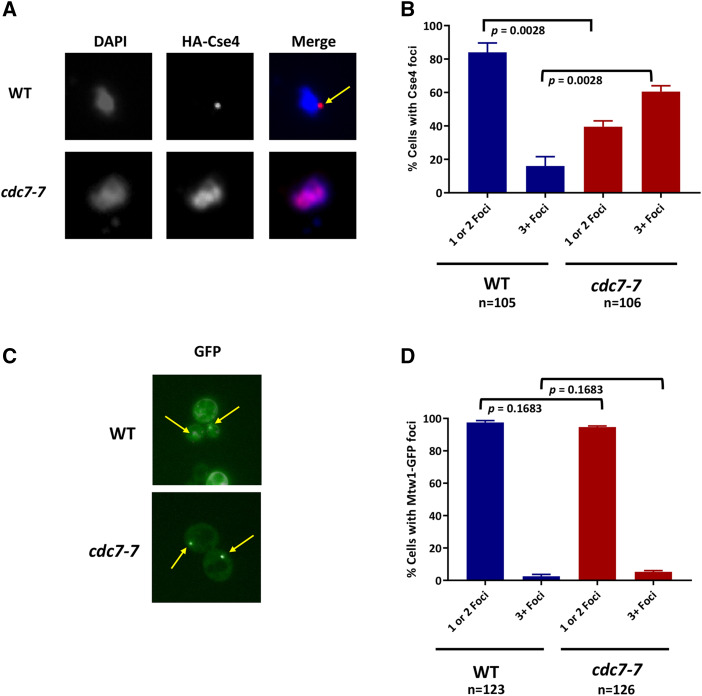
Cdc7 prevents mislocalization of Cse4 to non-centromeric regions. A. Cse4 is mislocalized in a cdc7 strain. Localization of Cse4 was examined using chromosome spreads prepared from nocodazole arrested wild type (RSY299) and cdc7-7 (RSY302) strains transformed with GAL-HA-CSE4 (pMB1597). HA-Cse4 was labeled with Cy3 (red) and DNA with DAPI (blue). Representative images of cells showing normal localization counted as nuclei with one or two Cse4 foci (WT) and mislocalization counted as nuclei with more than two foci or a diffuse signal in the nucleus (cdc7-7). Arrow indicates HA-Cse4 foci. B. Quantification of Cse4 localization from A. The graph displays the quantification of Cse4 localization as a percentage over total cell count. The SEM of two independent experiments is shown, WT 1 or 2 foci vs.
cdc7-7 1 or 2 Foci p-value = 0.0028; WT 3+ foci vs.
cdc7-7 3+ Foci p-value = 0.0028. C. The kinetochore protein Mtw1 is not mislocalized in a cdc7-7 strain. Wild type (YMB9337) and cdc7-7 (YMB9338) cells were transformed with Mtw1-GFP on a plasmid (pMB1058), grown to logarithmic phase of growth, and analyzed for Mtw1-GFP (green) foci with live cell imaging. Representative images of cells showing single Mtw1-GFP foci are shown. Arrow indicates Mtw1-GFP foci. D. Quantification of Mtw1-GFP localization from C. The graph displays the quantification of cells with one or two GFP foci (normal) or with greater than three foci (mislocalized) with the SEM of two independent experiments; WT 1 or 2 foci vs.
cdc7-7 1 or 2 Foci p-value = 0.1683; WT 3+ foci vs.
cdc7-7 3+ Foci p-value = 0.1683.